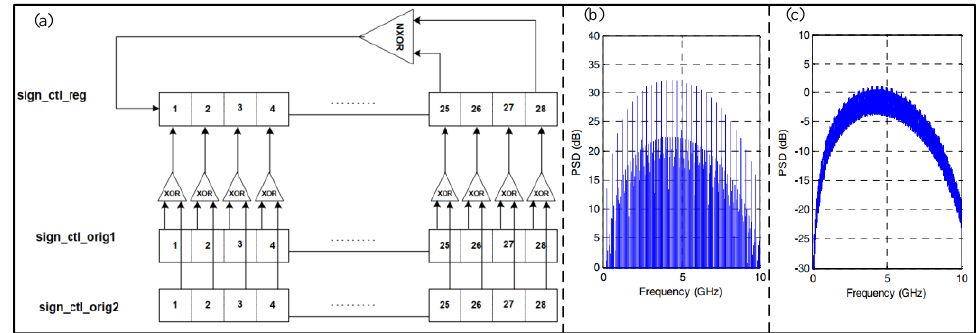
Figure 4. ( a ) Architecture of the two − layer LFSR. ( b ) PSD of original scrambler. ( c ) PSD of proposed scrambler. (Reprinted from [35], Copyright 2004, with permission from IEEE).